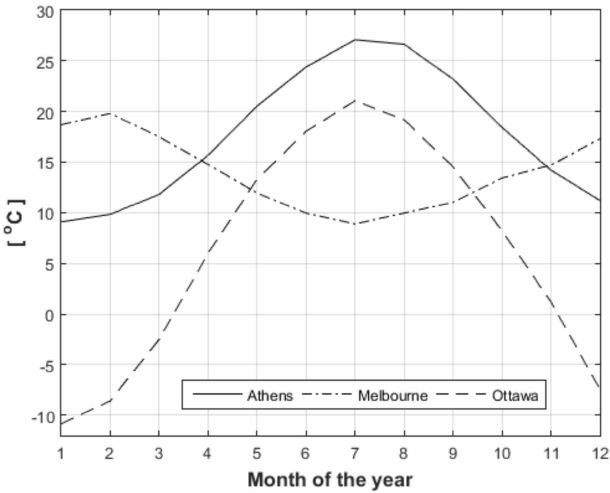
Figure 1. Monthly mean dry bulb ambient air temperature for all three cities. (Derived from TMY2,